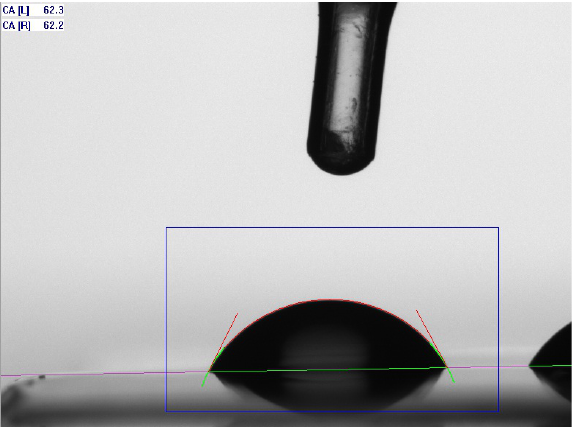
Figure 4. Contact angle measurements.